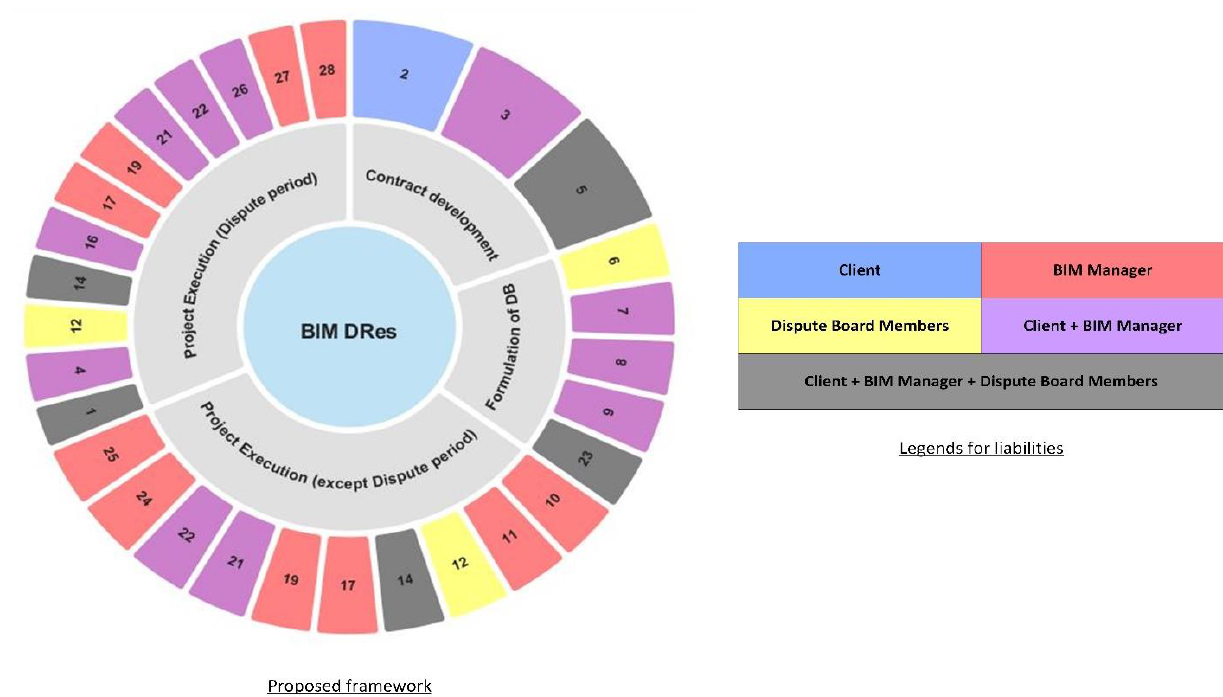
Figure 3. Framework for BIM incorporation in dispute resolution (BIM-DRes).